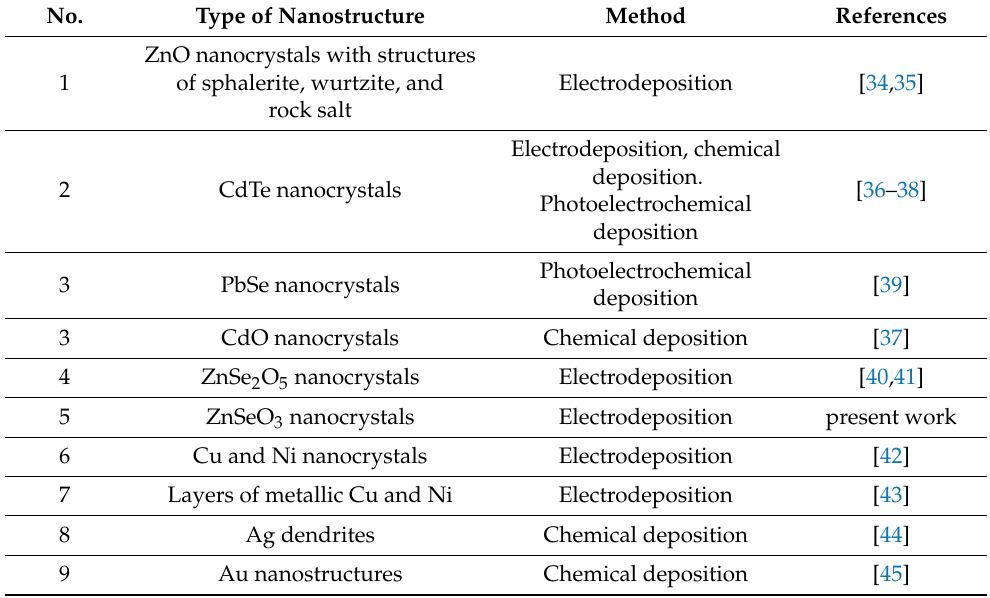
Table 1. Examples of nanostructures obtained by ion-track template synthesis in SiO 2 /Si track templates.